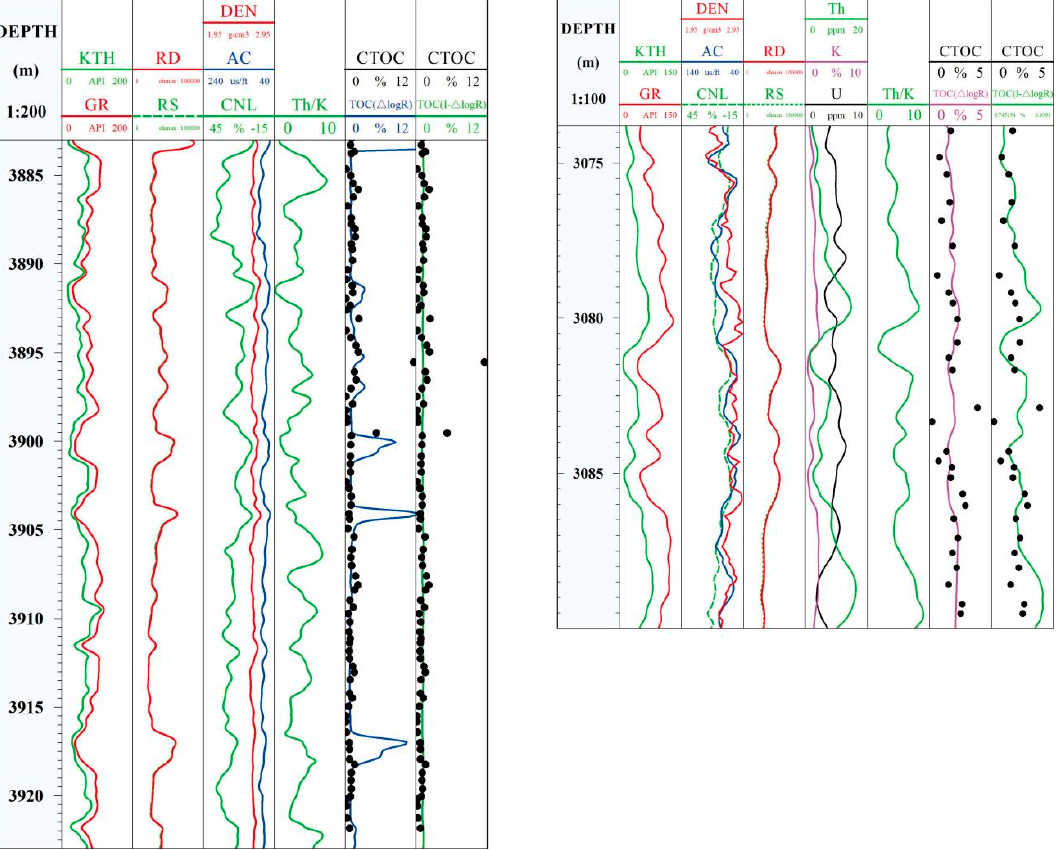
Figure 8. TOC calculation results of well A1 ( A ) and well B1 ( B ).